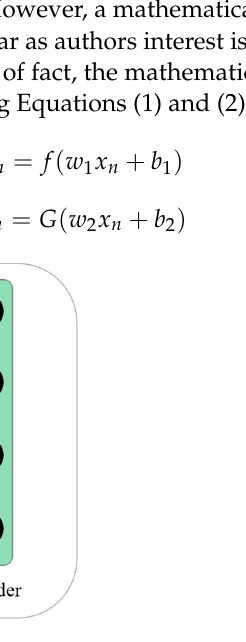
Figure 3. Internal architecture of autoencoder.